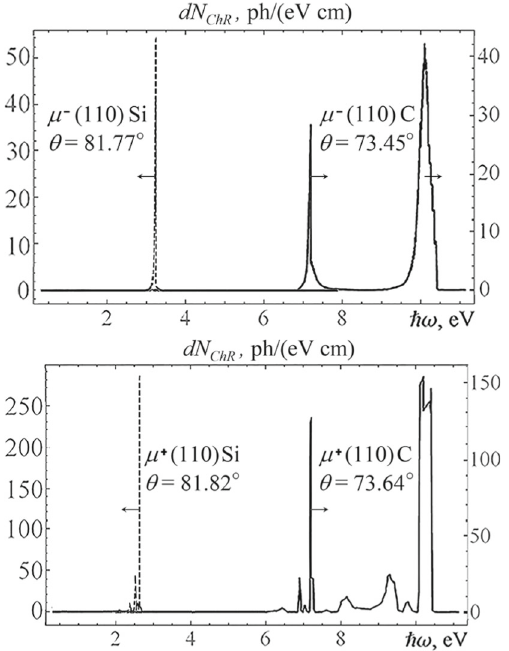
Fig. 5 Spectral distribution of ChCR by channeled 10 GeV muons ( μ − and μ + ) at the polar angle θ (from Table 1): θ (cid:2) 81 . 77 ◦ ( μ − ) and (cid:2) 73 . 0 ◦ ) Ch